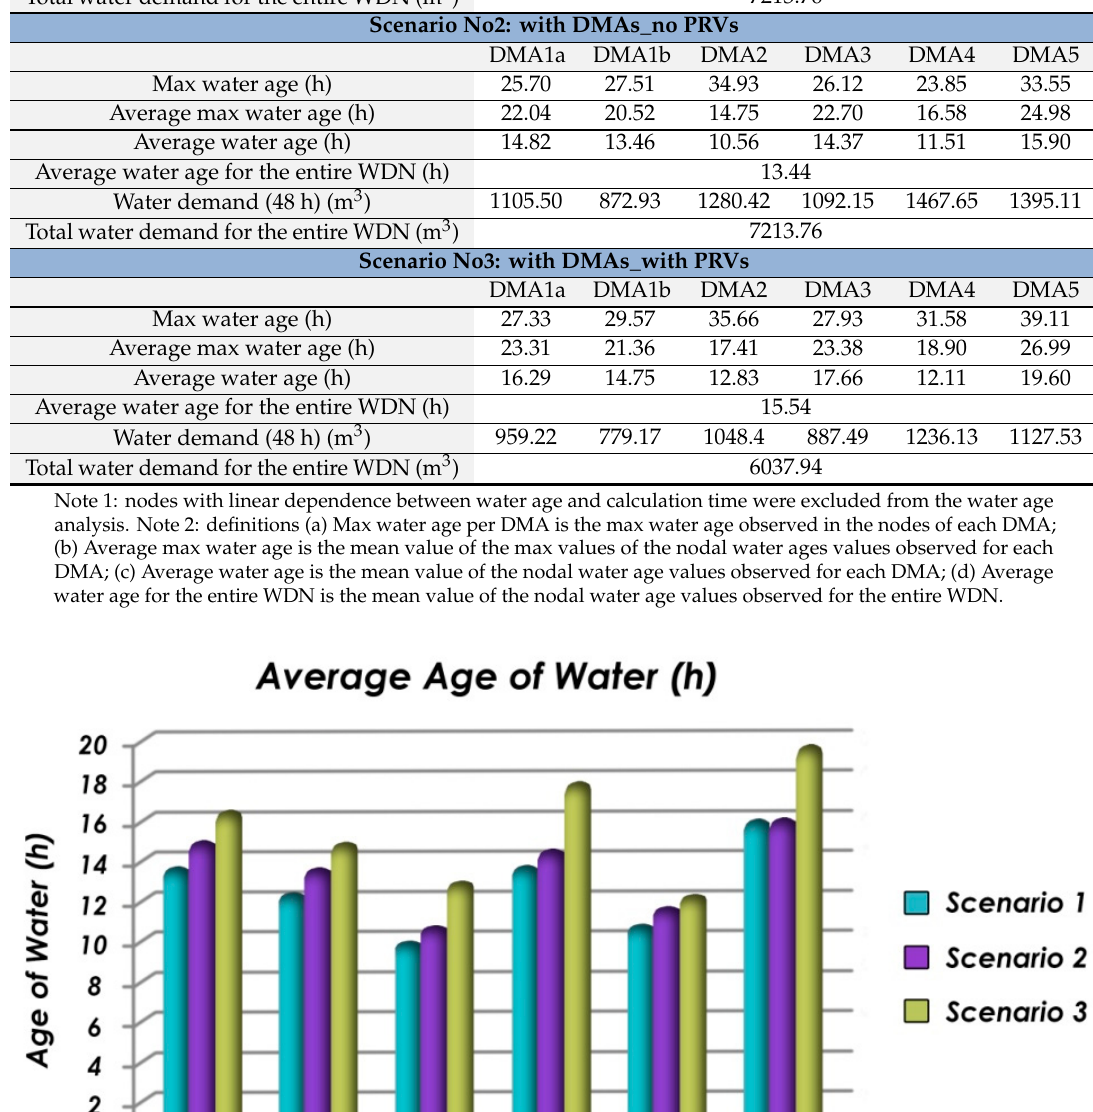
Figure 7. Water demand in each DMA for the three scenarios studied. The results proved that although significant pressure reduction can be achieved when PRVs are installed, the results on water age are not that favorable. More specifically, the mean water age for Scenario No2 was 13.44 hours, while for Scenario No3, after installing the PRVs, it raised up to 15.54 hours. The decrease in the water demand due to the pressure reduction and the model’s dependency on pressure, has a significant impact on the operation of the WDN. As the total water volume that is either consumed or lost is reduced, the water age increased, and thus the water quality deteriorated. In more detail, the total water demand at the nodes after the installation of the PRVs decreased by about 1176 m 3 over a period of 48 hours. 3.3. Water Age Reduction after Regulation of the PRVs WA is proven to grow as pressure is reduced, resulting in a decreased System Input Volume (SIV), so the hydraulic model is approached differently. Therefore, trials were set to strike a balance